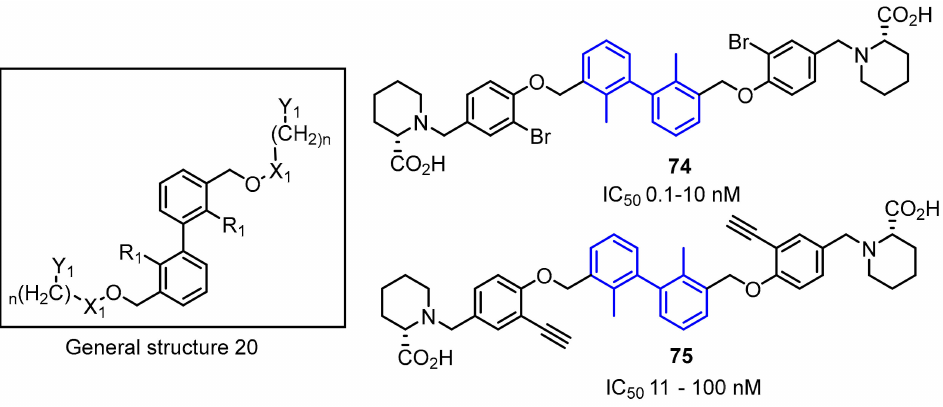
Figure 31. Examples of inhibitors 74 – 75 designed by Polaris Pharmaceuticals company